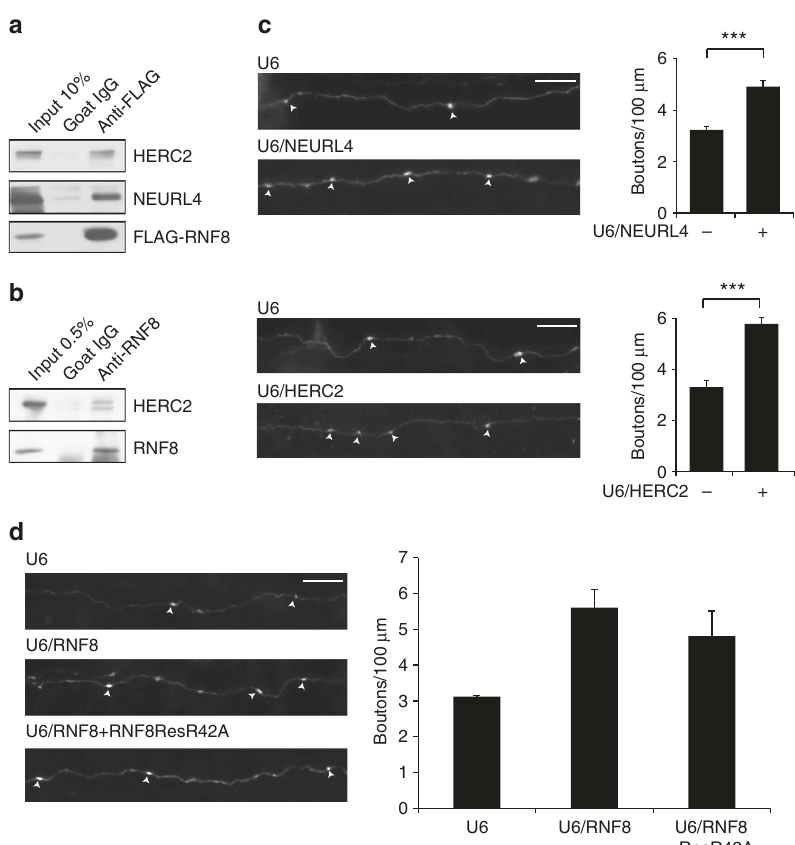
Fig. 6 RNF8 interacts with HERC2 and NEURL4 in the cerebellum and thereby suppresses parallel fi ber presynaptic differentiation in vivo. a Lysates of Neuro2A mouse neuroblastoma cells constitutively expressing FLAG-RNF8 were subjected to immunoprecipitation followed by immunoblotting. Coimmunoprecipitation of FLAG-RNF8 with endogenous HERC2 and NEURL4. b The cytoplasmic fraction of lysates of P7 rat cerebellum was subjected to immunoprecipitation followed by immunoblotting. Endogenous coimmunoprecipitation of RNF8 and HERC2 in the cytoplasmic fraction of the cerebellum. c P4 rat pups were electroporated with the NEURL4 RNAi, HERC2 RNAi, or control U6 plasmid and analyzed as in Fig. 1a. Knockdown of NEURL4 and HERC2 increased the density of presynaptic parallel fi ber boutons in the cerebellum in vivo (NEURL4 RNAi, *** p < 0.005, t test, n = 3 – 8 rats; HERC2 RNAi, *** p < 0.001, t test, n = 6 – 9 rats). d P4 rat pups were electroporated with the control U6 plasmid or RNF8 RNAi together with an RNF8Res mutant in which arginine 42 was replaced with alanine (RNF8ResR42A) or the control vector and with the GFP expression plasmid and analyzed as in Fig. 1a. Expression